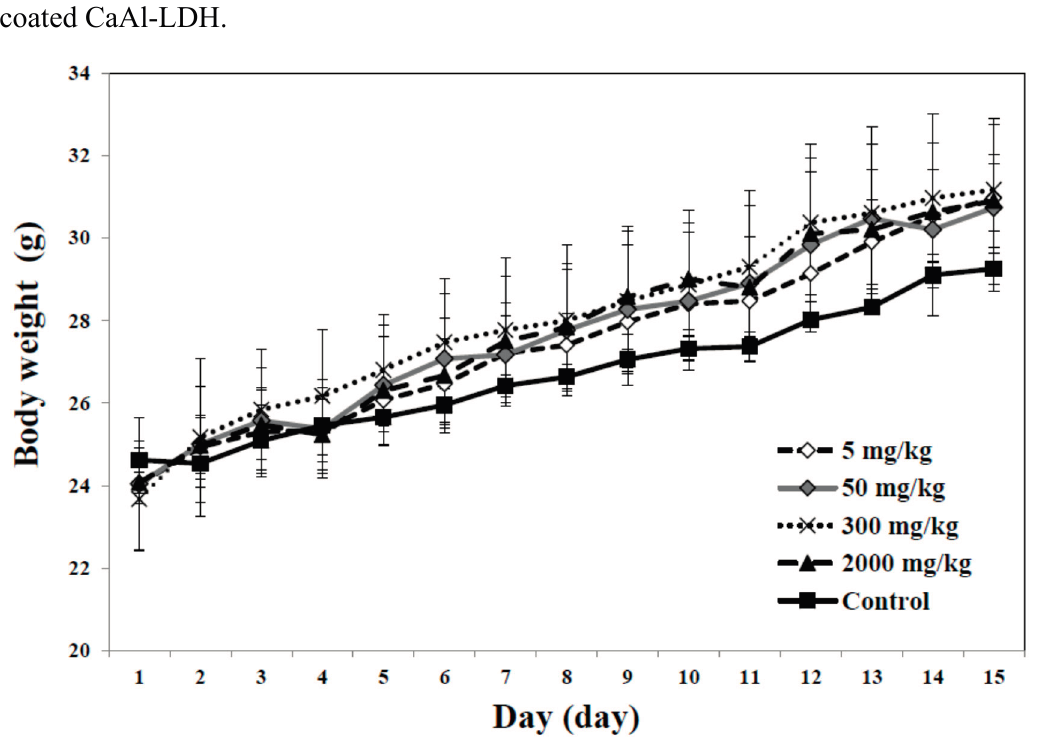
Figure 8. Change in body weight in mice after a single dose oral administration of E-coated